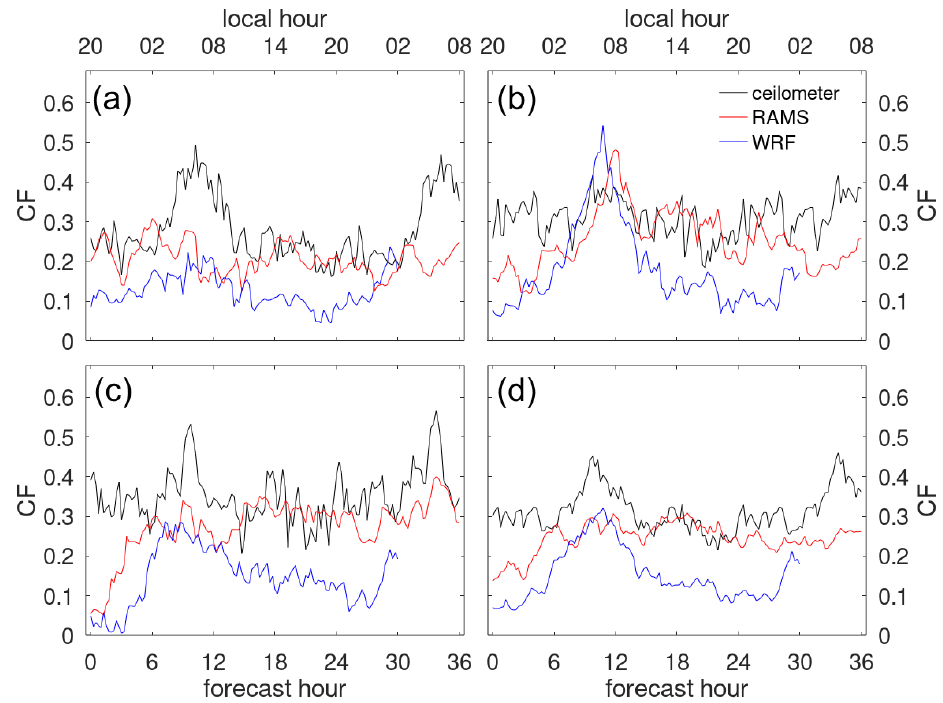
Figure 3. Monthly averaged 15-min cloud fraction (CF) for the ceilometer (black), RAMS (red), and WRF (blue) for ( a ) April, ( b ) May, ( c ) June, and ( d ) April to June.